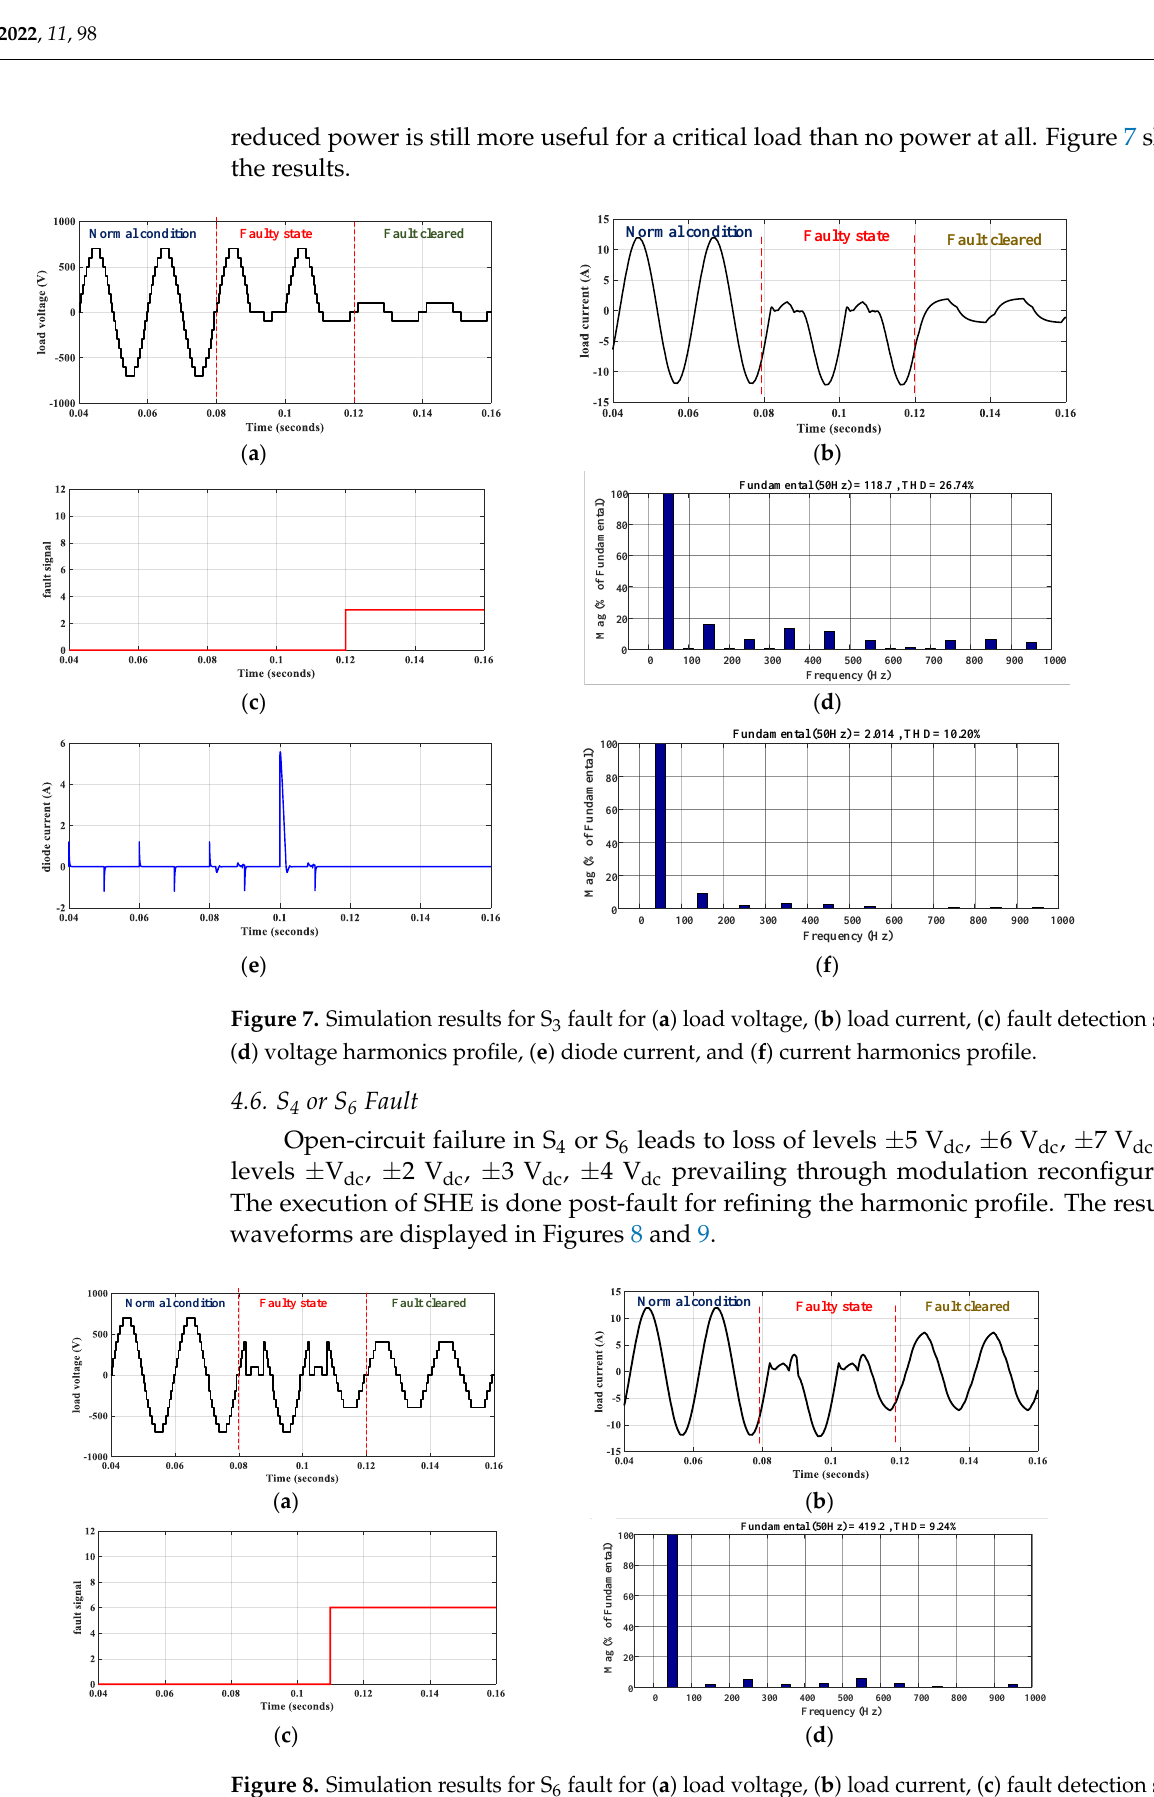
Figure 8. Simulation results for S 6 fault for ( a ) load voltage, ( b ) load current, ( c ) fault detection signal, and ( d ) voltage harmonics